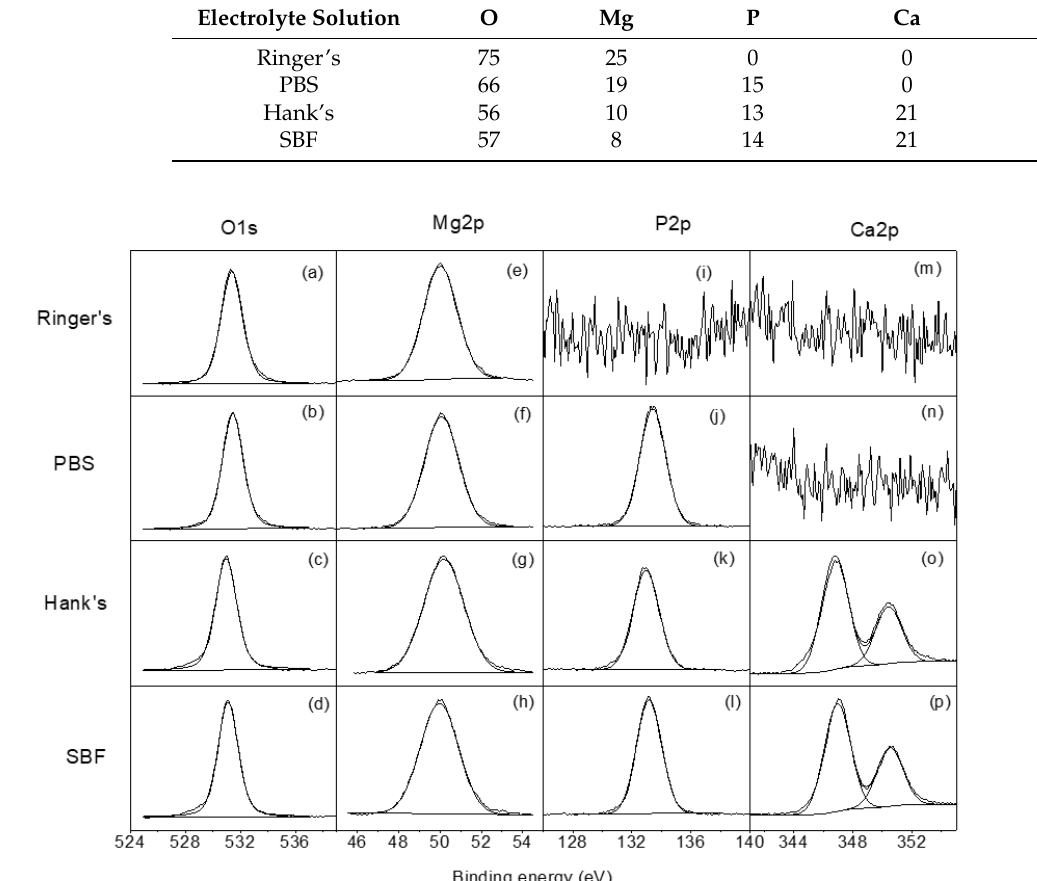
Table 3. Atomic percentage observed by XPS in the surface of the corrosion layer formed on alloys exposed to Ringer’s, PBS, Hank’s, and SBF solutions for 4 days of immersion. Electrolyte Solution